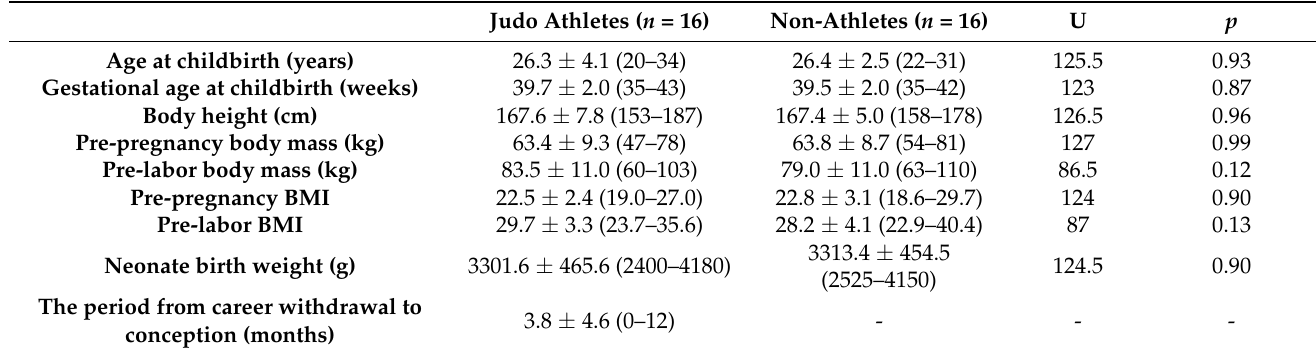
Table 3. Obstetric characteristics of elite judo athletes and non-athletes related to their first pregnancy and childbirth